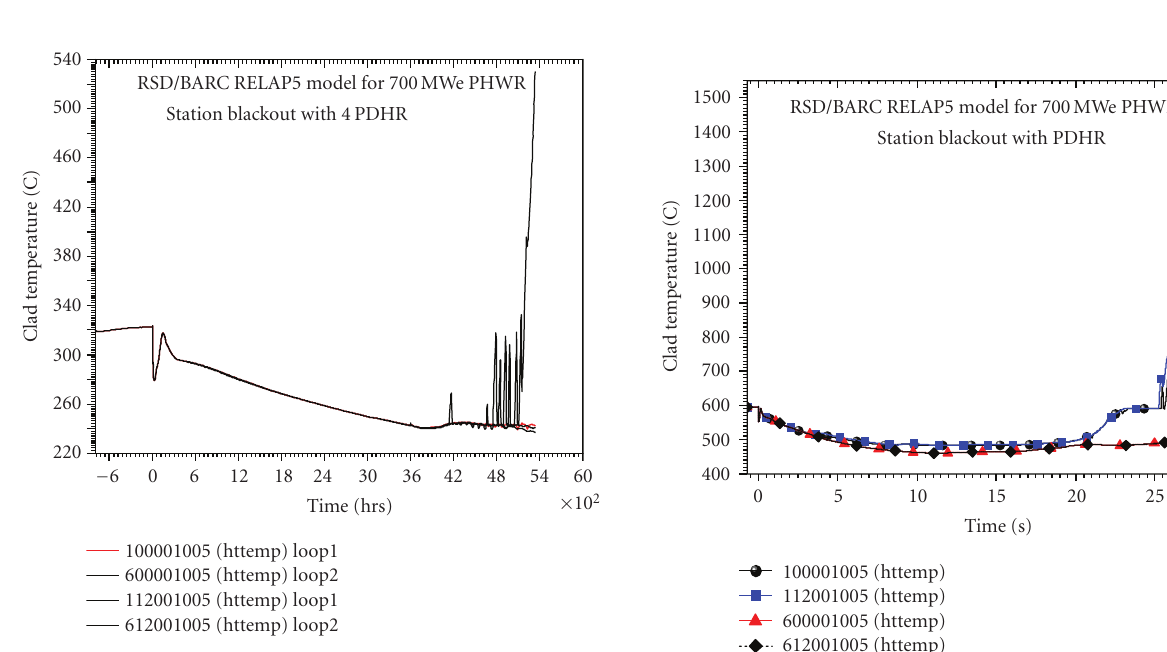
Figure 21: Clad temperature case-3PDHRs with loop